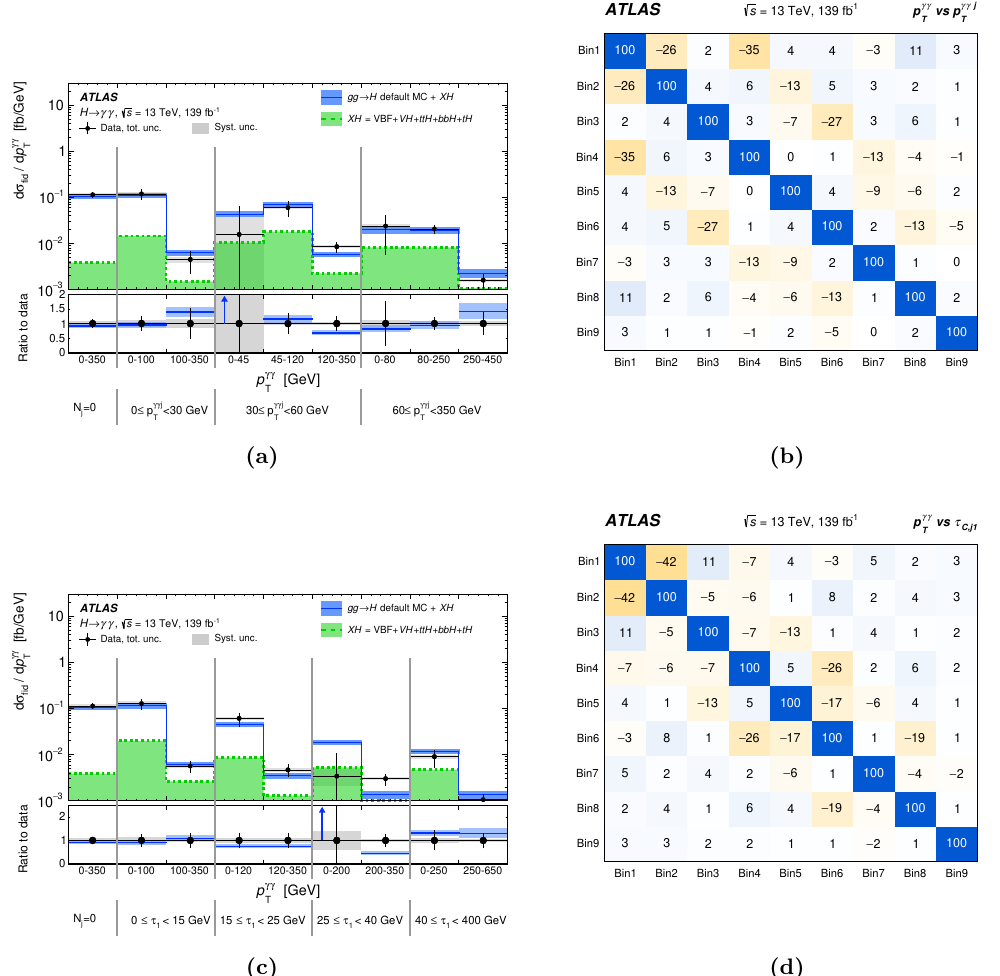
Figure 33. Double-differential particle-level fiducial cross-sections times branching ratio of (a) p γγ in bins of p γγj and (c) p γγ in bins τ together with the corresponding correlation matrices ((b) C,j 1 T T and (d)). The first bin corresponds to the case of N = 0 . The order of the bins in the correlation jet plots is the same as in the plots with the values of the